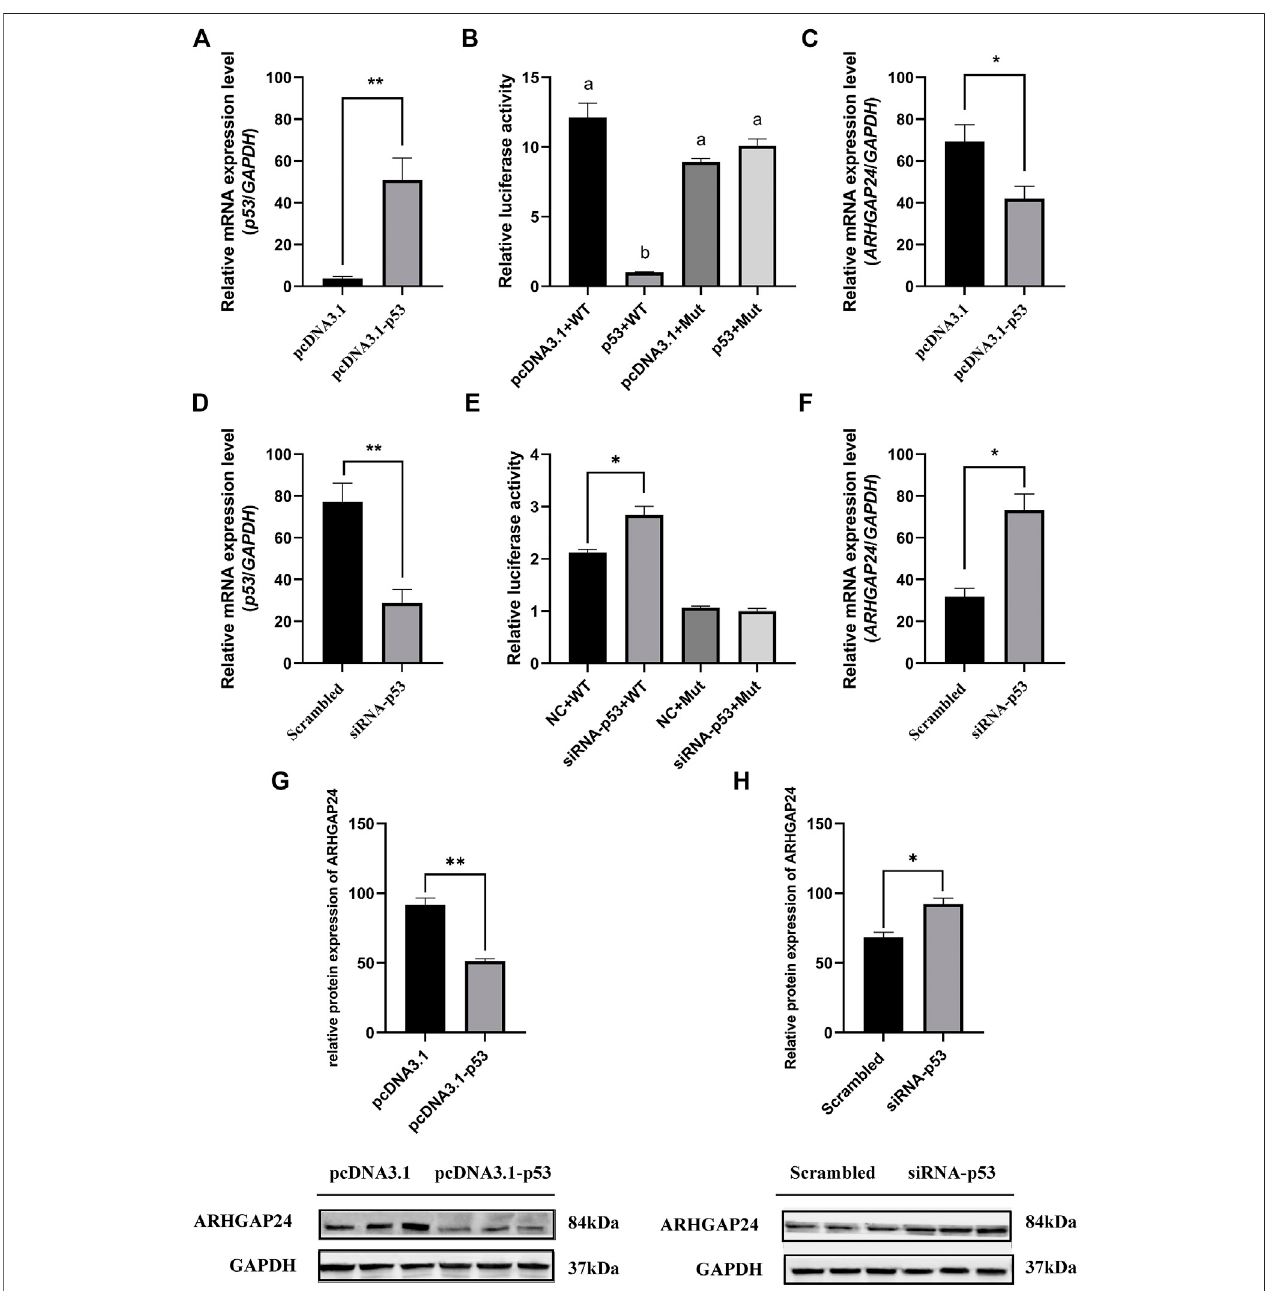
FIGURE5| Transcriptionfactorp53regulates ARHGAP24 geneexpressioninporcineneuralcells. (A) mRNAlevelofp53afterp53overexpression. (B) mRNAlevel of p53 after p53 knockdown. (C) Luciferase activity of the ARHGAP24 promoter region after p53 overexpression (D) Luciferase activity of the ARHGAP24 promoter regionafter p53 knockdown (E) mRNA level of ARHGAP24 after p53overexpression. (F) mRNAlevel of ARHGAP24 after p53 knockdown. (G) Western blot analyses of ARHGAP24 protein expression in porcine neural cells transfected with pcDNA3.1-p53 and pcDNA3.1 (+). (H) Western blot analyses of ARHGAP24 protein expression in porcine neural cells transfected with the scrambled and siRNA-p53 groups. The protein levels were normalized to GAPDH. * p < 0.05 and ** p < 0.01. Different letters (a, b, c, etc .) before the columns indicate that the difference is signi fi cant ( p < 0.05)